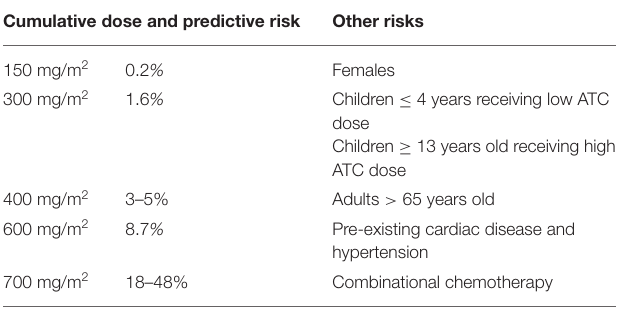
TABLE 1 | Factors associated with increased risk of DIC. Cumulative dose and predictive risk Other risks